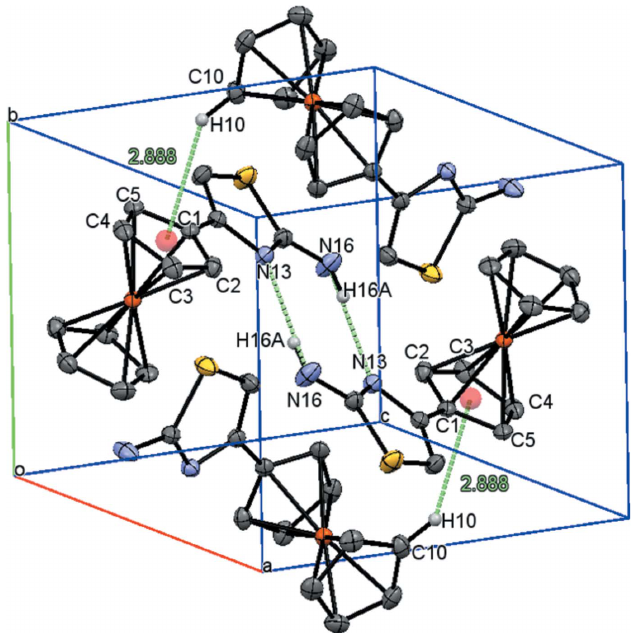
Figure 2 The packing of the title compound. The dotted lines indicate inter- molecular hydrogen bonds. All H atoms not involved in these interactions have been omitted for clarity.